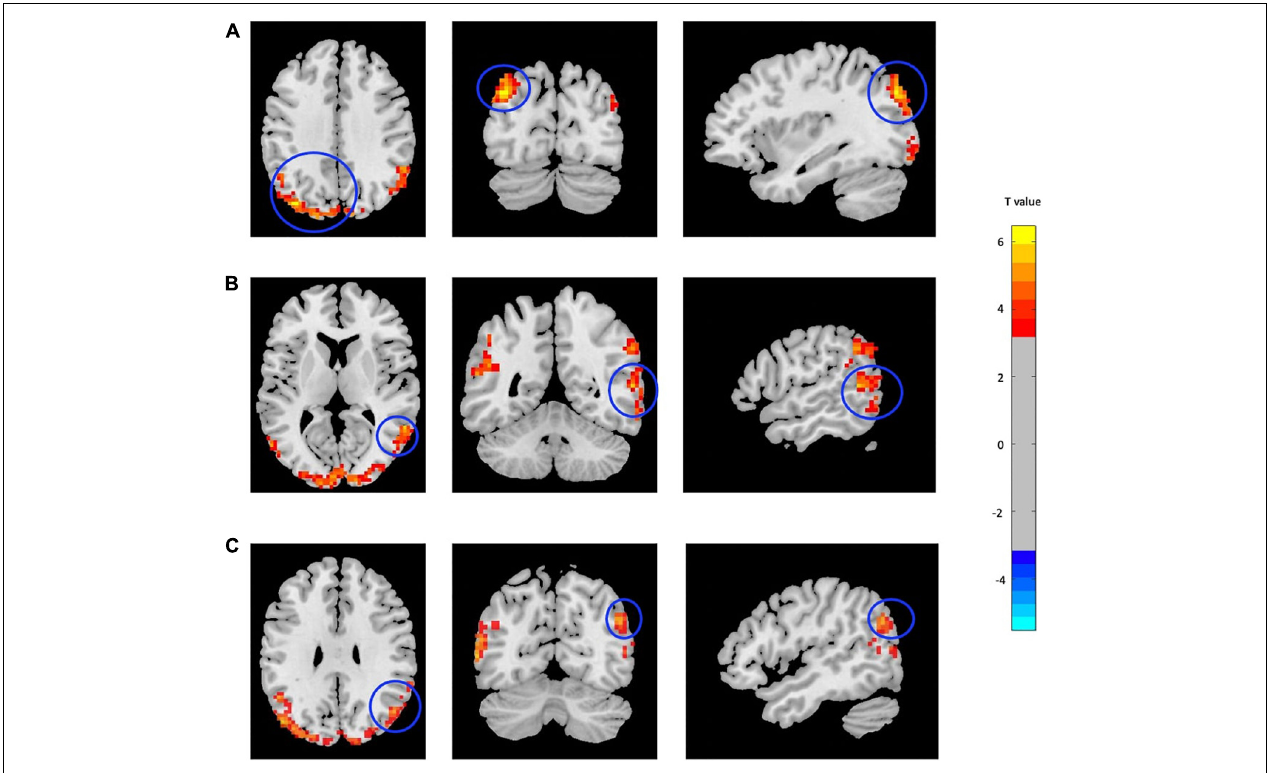
FIGURE 1 | Increased fALFF in mTBI patients compared with controls in the clusters including (A) Occipital_Mid_L, (B) Temporal_Mid_R, and (C) Angular_R ( p -value < 0.001, FDR-corrected). The range of t -values is represented by the color bar. Hot colors corresponding with increased fALFF values in the mTBI group. *Note that the right side of the image as displayed is the right side of the